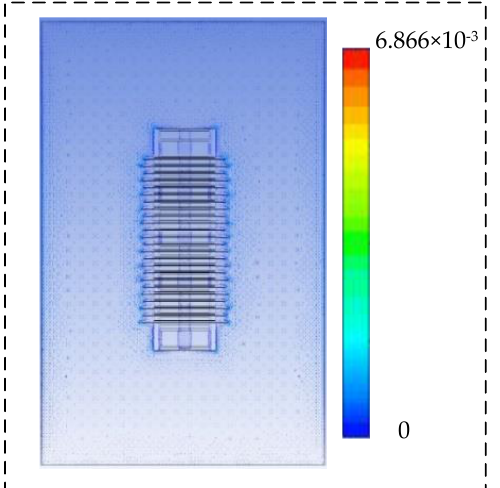
Figure 12. The fluid flow velocity diagram.